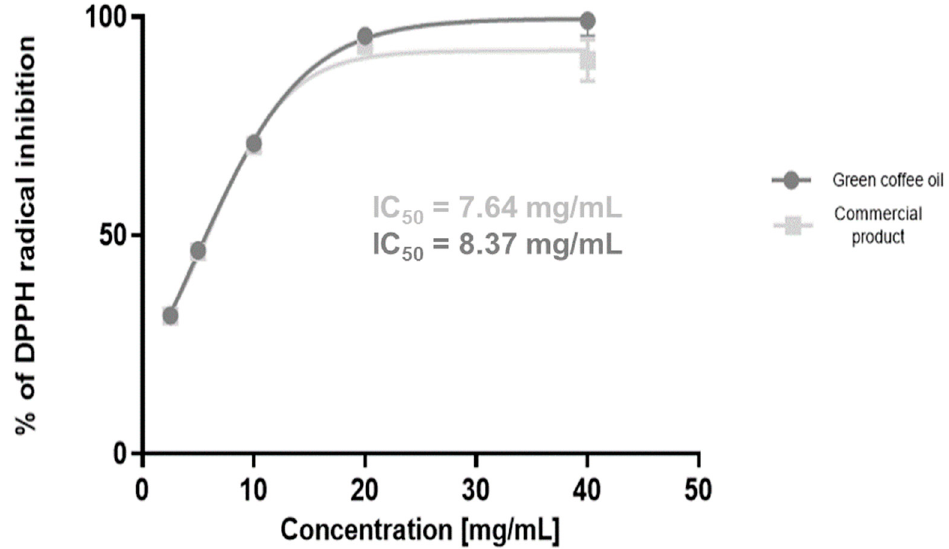
Figure 3. DPPH scavenging activity for green coffee oil. The assay was performed in triplicate and the mean values were used to calculate the IC 50 /EC 50 .